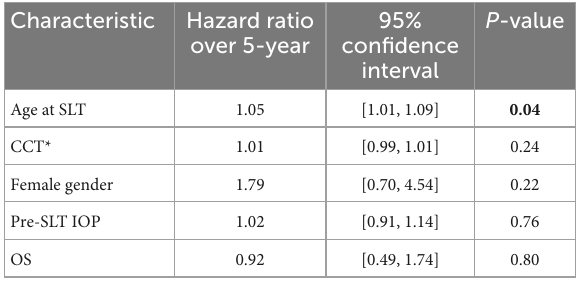
in the 5-year follow-up period and had complete OCT data.